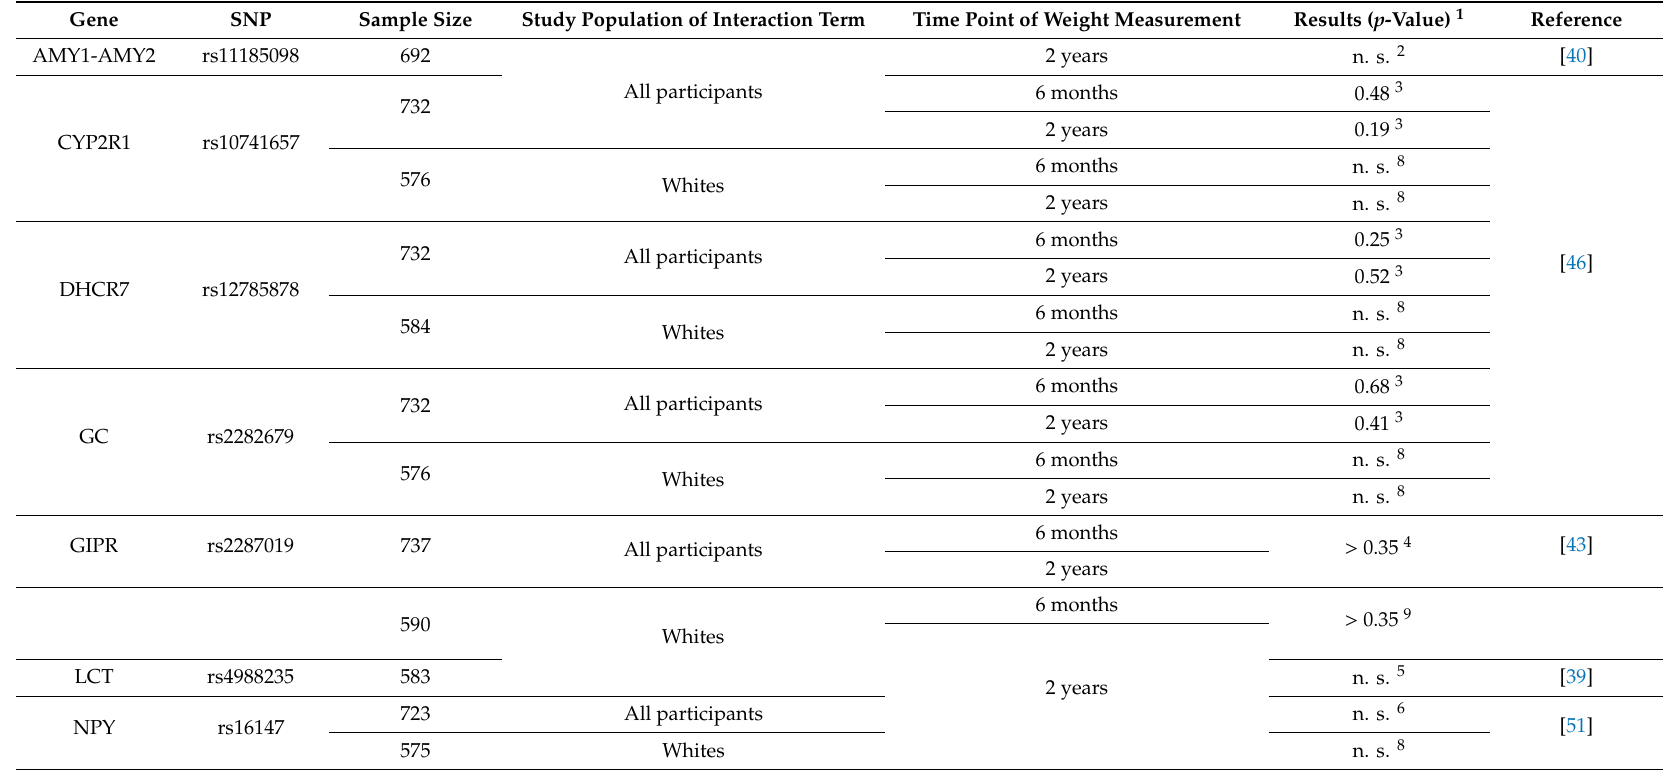
Table 4. Interaction of genotype and protein intake on weight